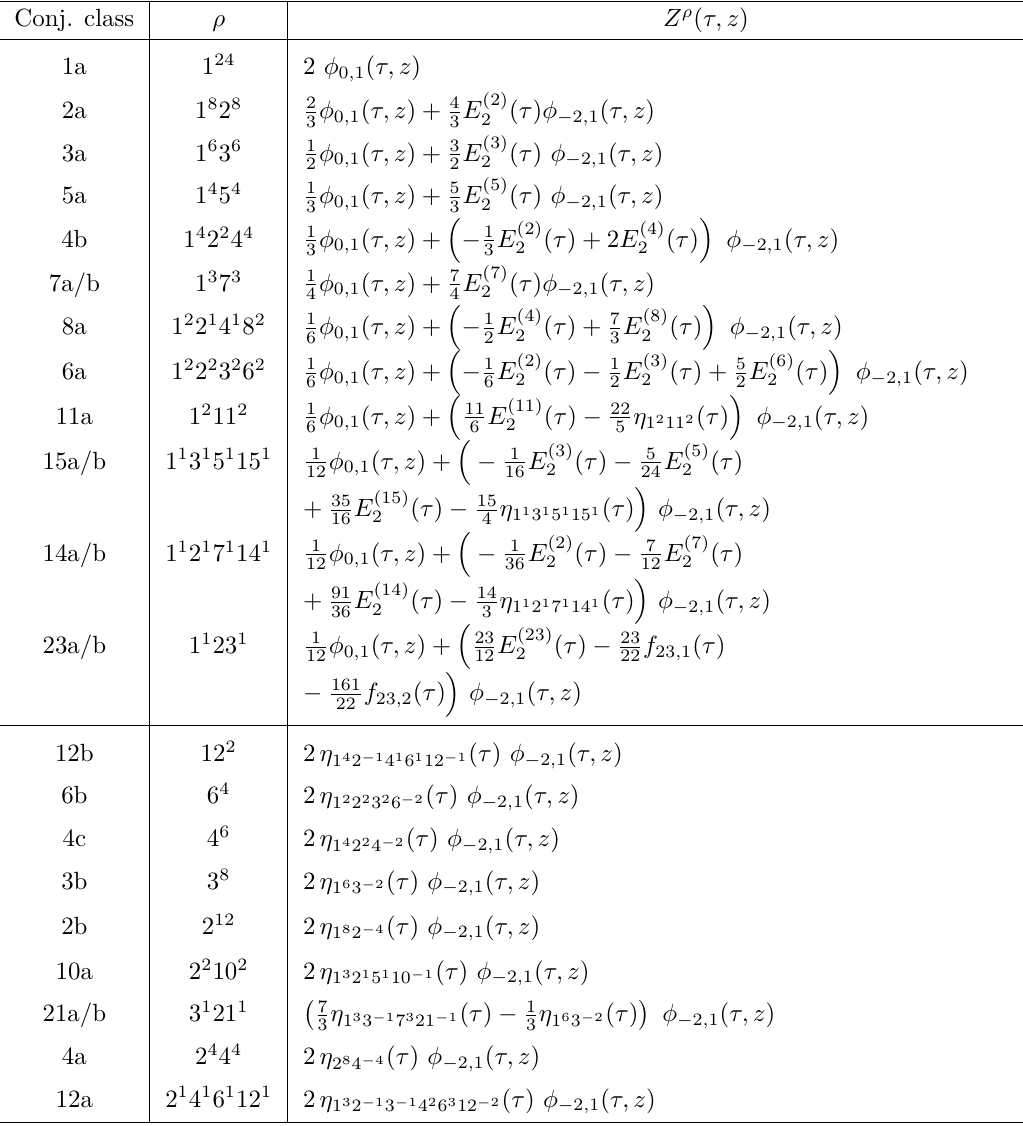
Table 1 . The Jacobi forms for all conjugacy classes of M 24